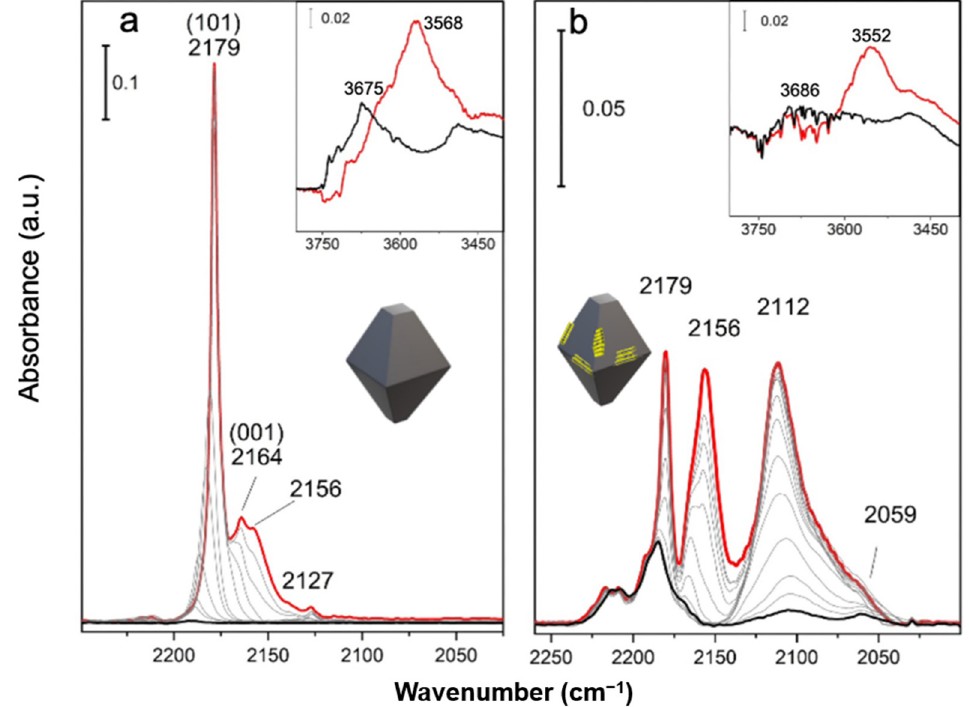
Figure 7. FTIR spectra of CO adsorbed at 77 K (40 Torr, red line) at decreasing coverage up to the residual pressure of 4 × 10 − 4 Torr (black line) on the surface of: ( a ) TiO 2 bipy and ( b ) MoS 2 /TiO 2 bipy. The insets show the OH vibrational modes regions before (black line) and after CO dosage (red line).